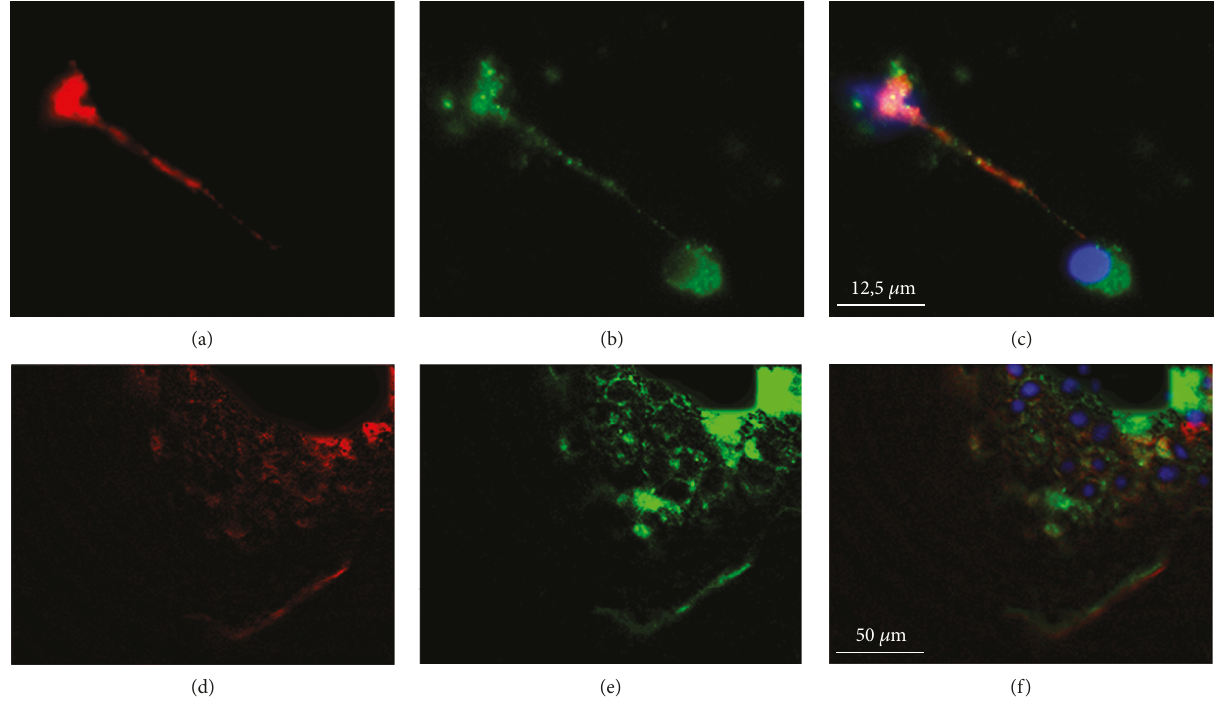
Figure 6: In vitro expression of Sema3D receptors. (a, b, c) Retinal dissociated culture expressing the receptor Plexin A1 (red) in Tuj-1-positive cells (green) and nuclear staining (DAPI). (d, e, f) Retinal explant cells expressing the receptor Plexina A1 in Tuj-1-positive cells. N = 3 per group. Scale bars: (a, b, c) 12.5 μ m, (d, e, f) 50 μ